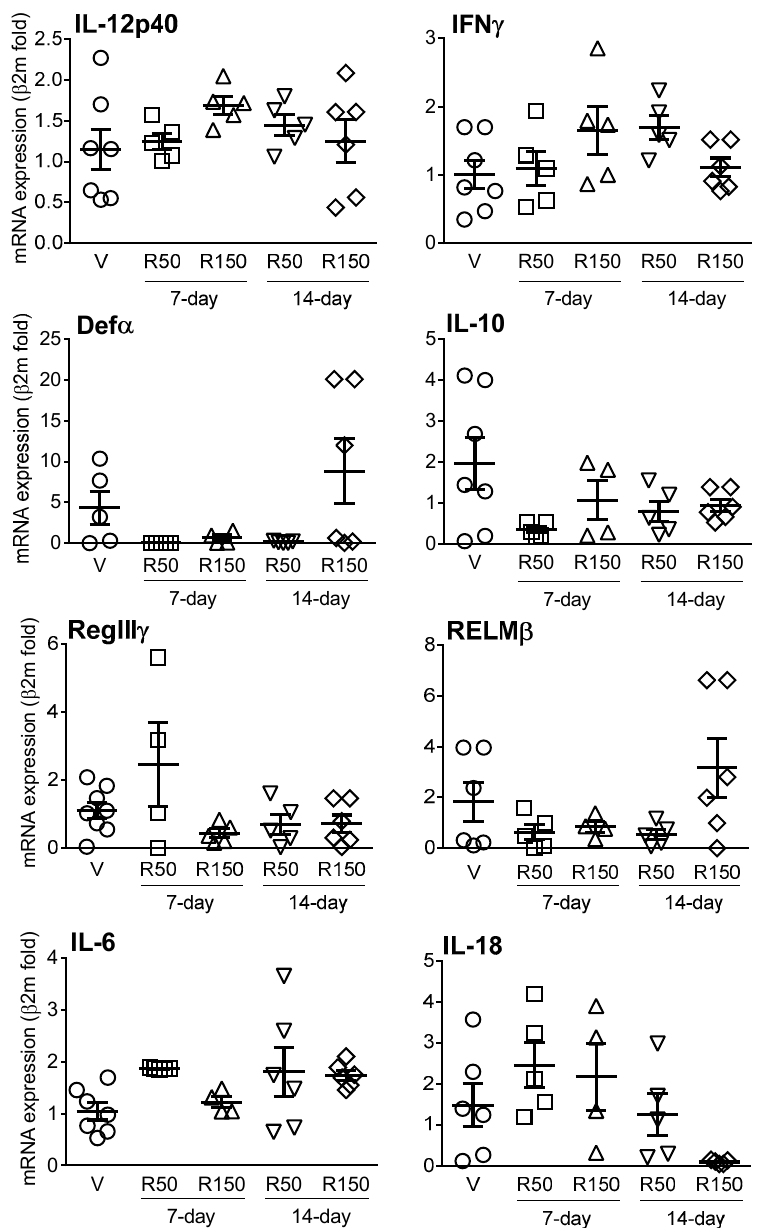
Figure 8. Effects of rifaximin on the colonic expression of immune-related markers. Each point represents an individual animal; the horizontal lines with errors correspond to the mean ± SEM. For the sake of clarity, and since no differences were observed among them, vehicle-treated animals have been merged in a single group ( n = 8). V: Vehicle; R50: rifaximin at 50 mg/kg; R150: rifaximin at 150 mg/kg.